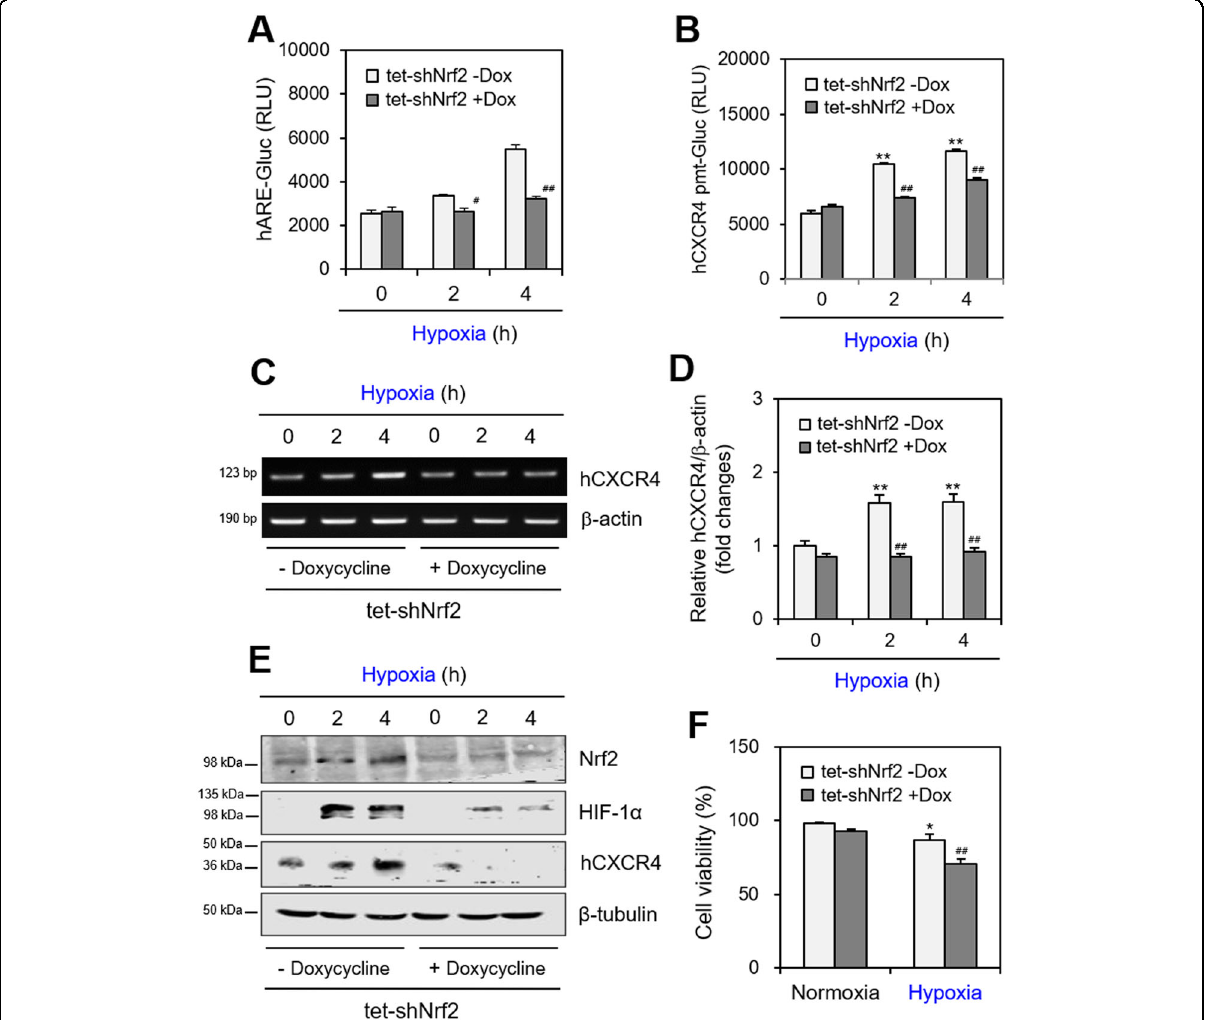
Fig. 4 hCXCR4 expression was attenuated by tetracycline (tet)-inducible Nrf2-knockdown. A , B Nrf2-knockdown (KD) cells were prepared by the infection with lentivirus-packaged shNrf2, colony selection and the treatment with 0.2 μ g/ml doxycycline (Dox) for 48 h. Then, the infected shNrf2-positive control (tet-shNrf2, − Dox) and Nrf2-KD (tet-shNrf2, + Dox) cells were transfected with pEZx-PG02-hARE-Gluc plasmid DNA ( A ) or pEZx-PG02-hCXCR4-Gluc promoter (pmt) ( B ). 30 h after transfection, cells were incubated under hypoxic condition and Gluc activity of hARE ( A ) or hCXCR4-pmt ( B ) was measured by using luminometer. C – F The infected shNrf2-positive control (tet-shNrf2, − Dox) and Nrf2-KD (tet-shNrf2, + Dox) WiL2-NS cells were incubated under normoxic or hypoxic conditions. RNA was extracted by using Nucleozol. mRNA of hCXCR4 was measured by qPCR ( C ) or RT-PCR ( D ). Cell lysates were prepared and the protein level of each protein was measured by using western blot analysis ( E ). Cell viability was measured by using trypan blue exclusion assay ( F ). Each experiment was performed at least fi ve times. Data in bar graphs represented the means ± SD. * p < 0.05, **p < 0.01; signi fi cantly different from control group under normoxic condition. # p < 0.05, ## p < 0.01; signi fi cantly different from shNrf2-positive control (tet-shNrf2, − Dox) at each time point ( A – C , F